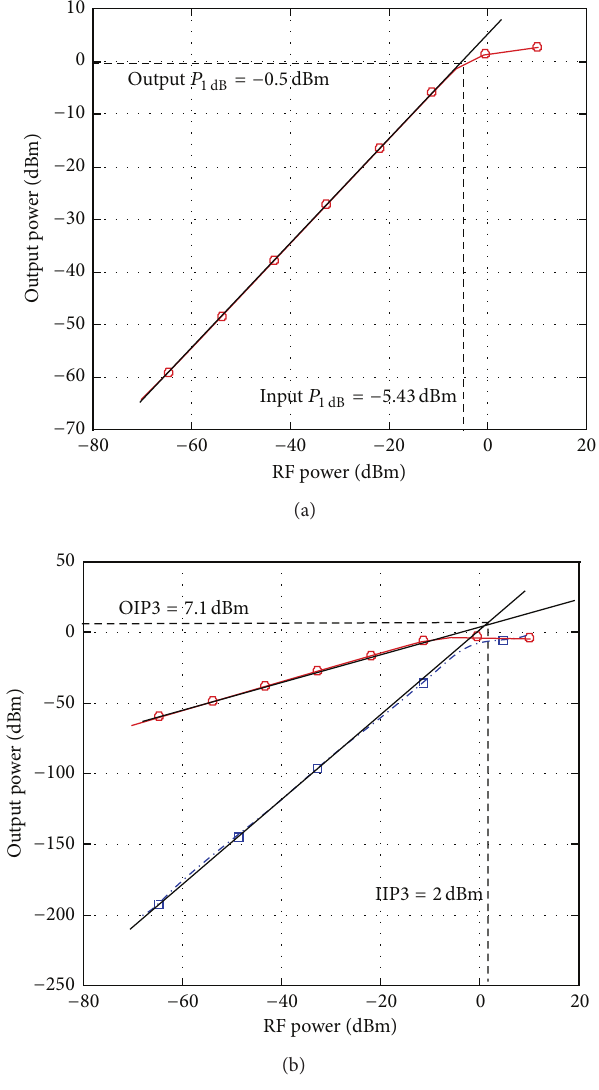
Figure 3: (a) 1dB compression point. (b) Third-order intercept